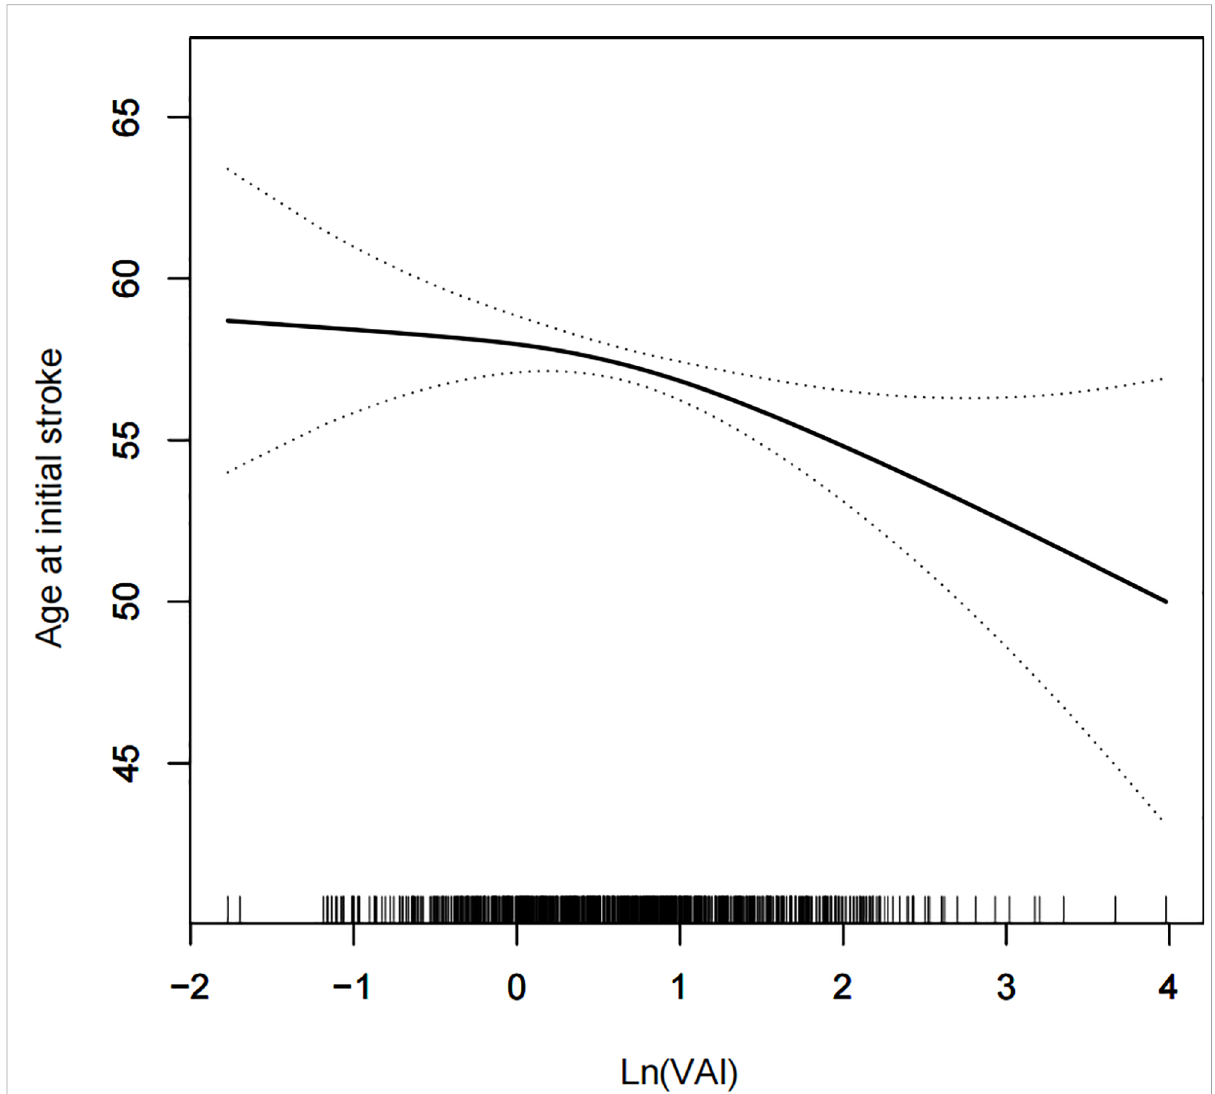
FIGURE 3 Density dose-response relationship between VAI with onset age of stroke. The area between the upper and lower dashed lines is represented as 95% CI. Each point shows the magnitude of the VAI and is connected to form a continuous line. Adjusted for all covariates except effect modi fi